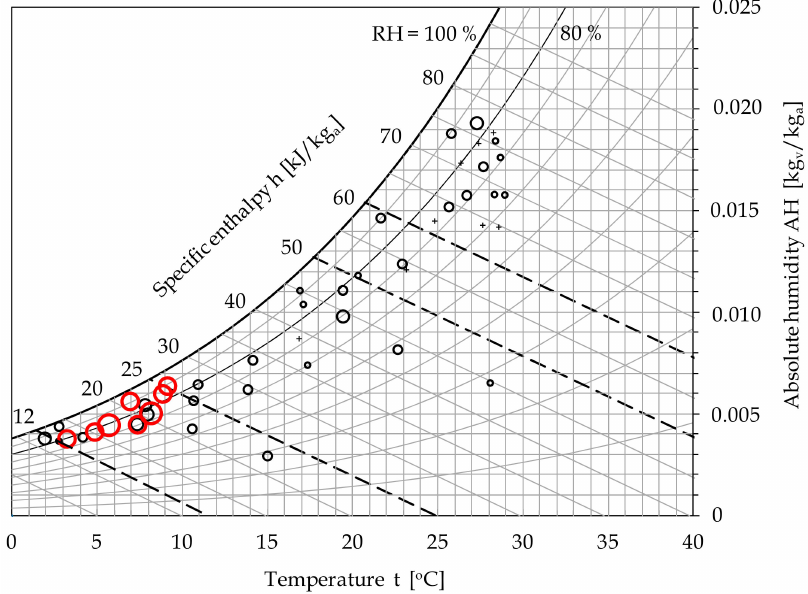
Figure 1. Elaboration of the infectivity data extracted from the study by Sajadi et al.